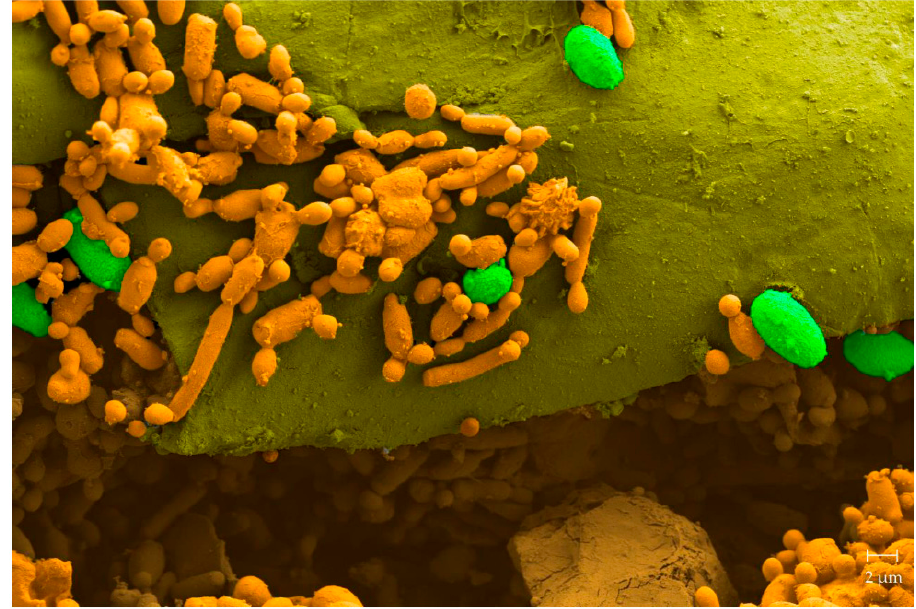
Figure 4. Enzyme production via selected yeasts and their lytic effect on the phytopathogenic fungus cell wall. Reprinted with permission from Hernandez-Montiel et al. [129]. Copyright 2021 MDPI.